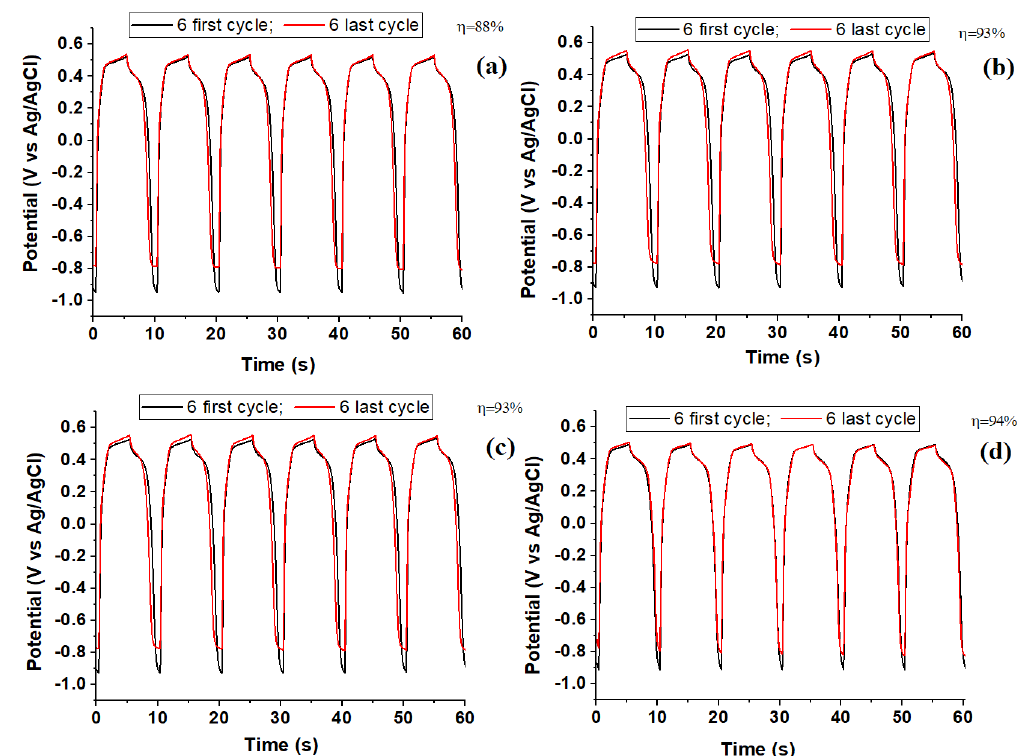
Figure 8. First six cycles and last five cycles of charge–discharge curves for ( a ) TiO 2 , ( b ) 0.5% Cu-TiO 2 ,